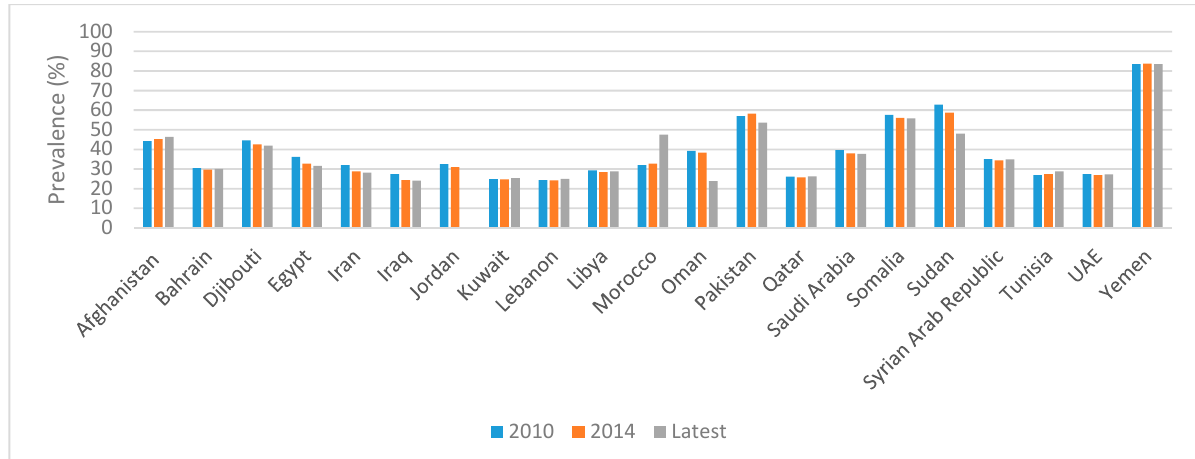
Figure 3. Trends in the prevalence of anemia amongst U5C in countries of the EMR. References: The 2010 and 2014 data were based on the WHO GHO Database [28]. The latest data were also based on the 2016 WHO GHO Database [28], with the exception of those for Morocco, Oman, Pakistan, and Sudan; they were based on the recent Moroccan NNS 2019–2020 [37], Oman NNS 2017 [36], Pakistan NNS 2018 [32], and Sudan Simple Spatial Survey Method (S3M II) [39], respectively. Anemia was defined as an Hb concentration < 110 g/L, adjusted for altitude. Abbreviations: EMR: Eastern Mediterranean Region; GHO: Global Health Observatory; Hb: hemoglobin; NNS: National Nutrition Survey; U5C: underfive children; UAE: United Arab Emirates; WHO: World Health Organization.